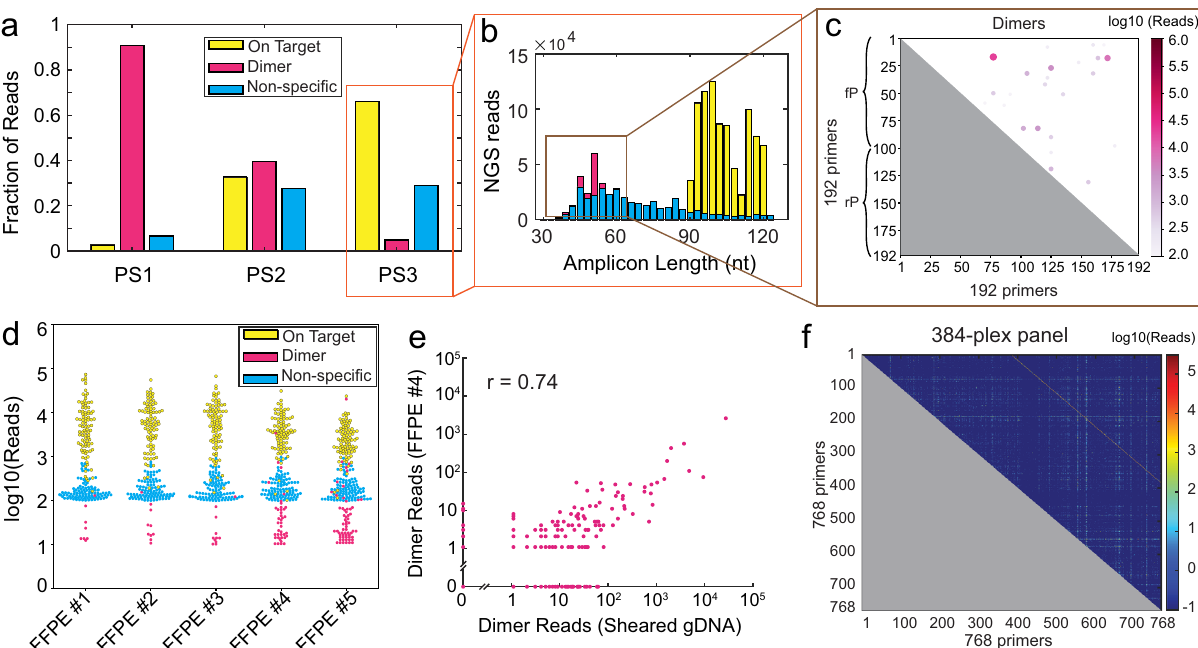
Fig. 3 Experimental NGS results for SADDLE-designed primer sets. a Distribution of reads observed in NGS library constructed using PS1, PS2, and PS3. On Target reads are de fi ned as those that aligned to the intended amplicons; Dimer reads are de fi ned as those whose insert lengths are smaller than the sum of the two primer lengths; all other reads were classi fi ed as Non-speci fi c. The vast majority of Non-speci fi c reads align to other regions of the human genome, via a non-cognate pair of forward and reverse primers. The fraction of NGS reads mapped to Dimers dramatically decreases from PS1 to PS2 to PS3. b Distribution of NGS reads in the three primer set libraries. c Distribution of observed primer dimers, based on aligned reads. Because forward primers (fP) can also form primer dimers with other forward primers, we aligned the fi rst and last 25 nucleotides of each NGS read to the merged set of fP and rPs, with primers 1 through 96 in the diagram showing fPs and primers 97 through 192 showing rPs. For clarity of visualization, the log number of reads of observed primer dimers are displayed via both coloration and circle size. d Performance of the PS3 primer set of formalin- fi xed paraf fi n-embedded (FFPE) tissue samples from deidenti fi ed lung cancer patients. Because the NGS libraries for these fi ve samples differed slightly in total reads, here we plotted the distribution of reads normalized to 1 million reads. e The observed primer dimer species and their corresponding NGS reads were relatively similar between cell line genomic DNA and FFPE samples. f Demonstration of a 384-plex primer set designed by SADDLE (768 primers). The main diagonal shows On Target reads. Only about 1% of all reads were primer dimers (Supplementary Section